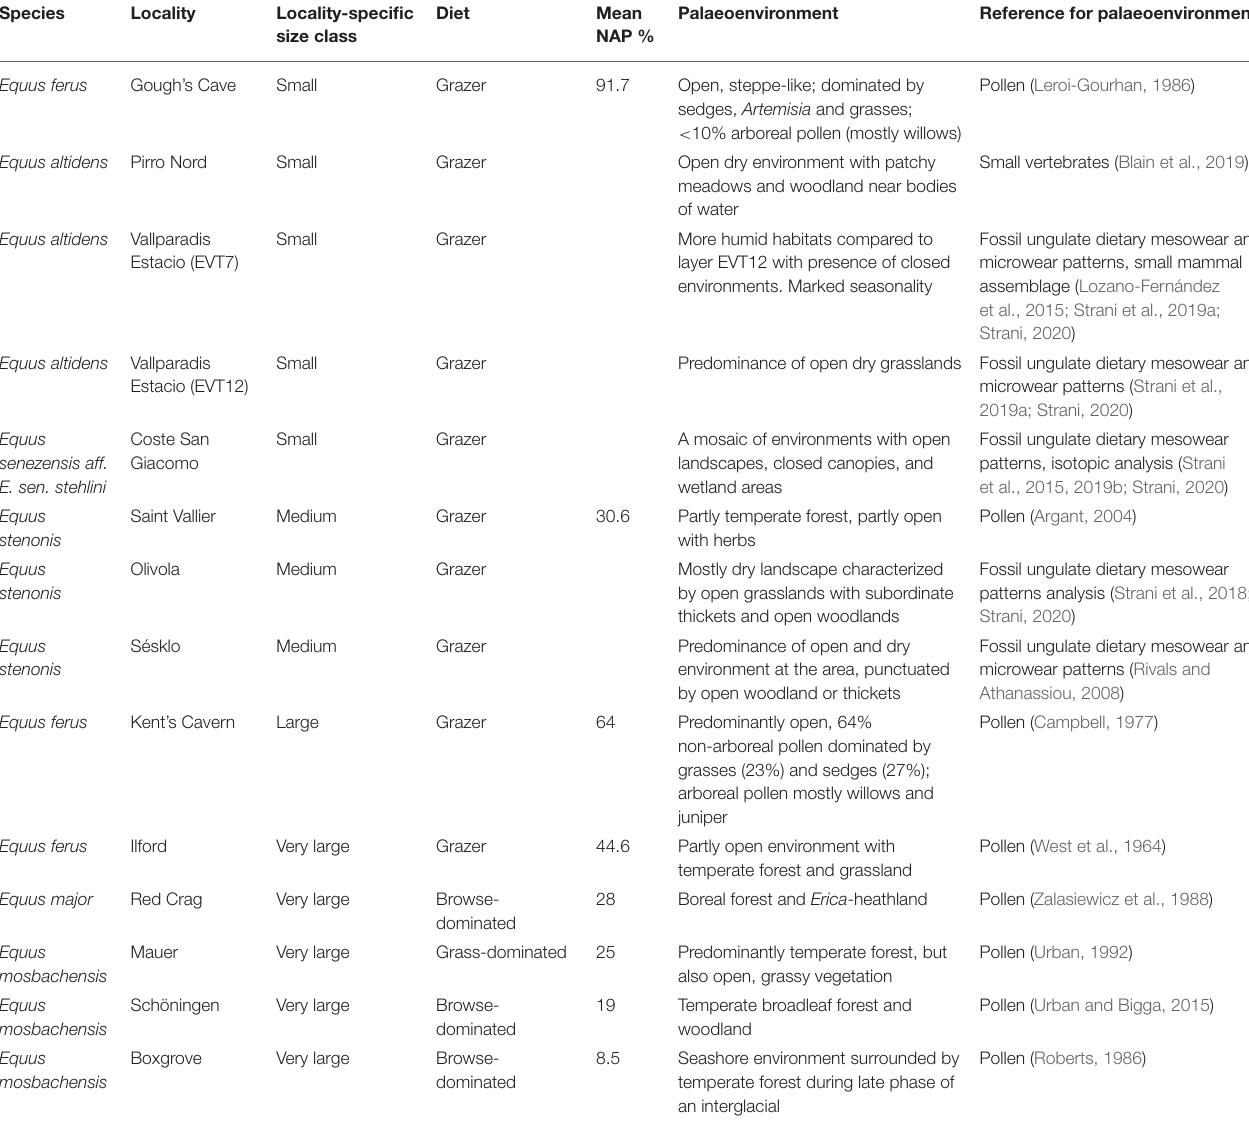
TABLE 3 | Palaeoenvironmental interpretations of some Equus species/populations with different body size in the Pleistocene of Europe, from older to more